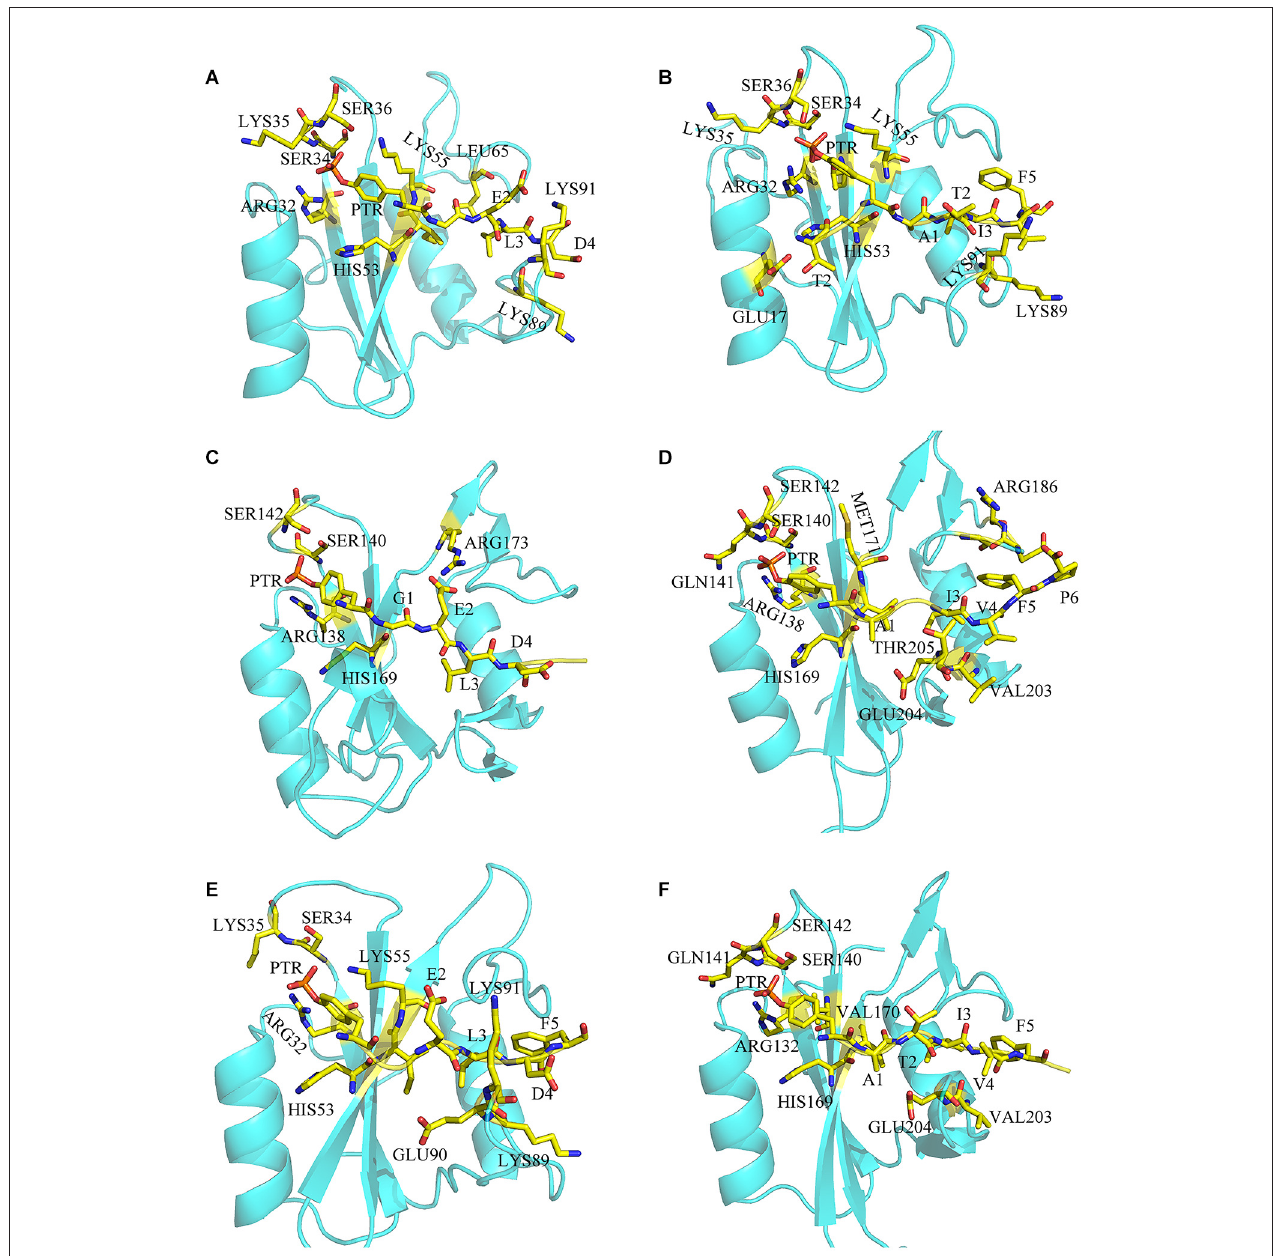
FIGURE 3 | The binding details of systems N-SH2-ITIM (A) , N-SH2-ITSM (B) , C-SH2-ITIM (C) , C-SH2-ITSM (D) , and DUAL (E,F)